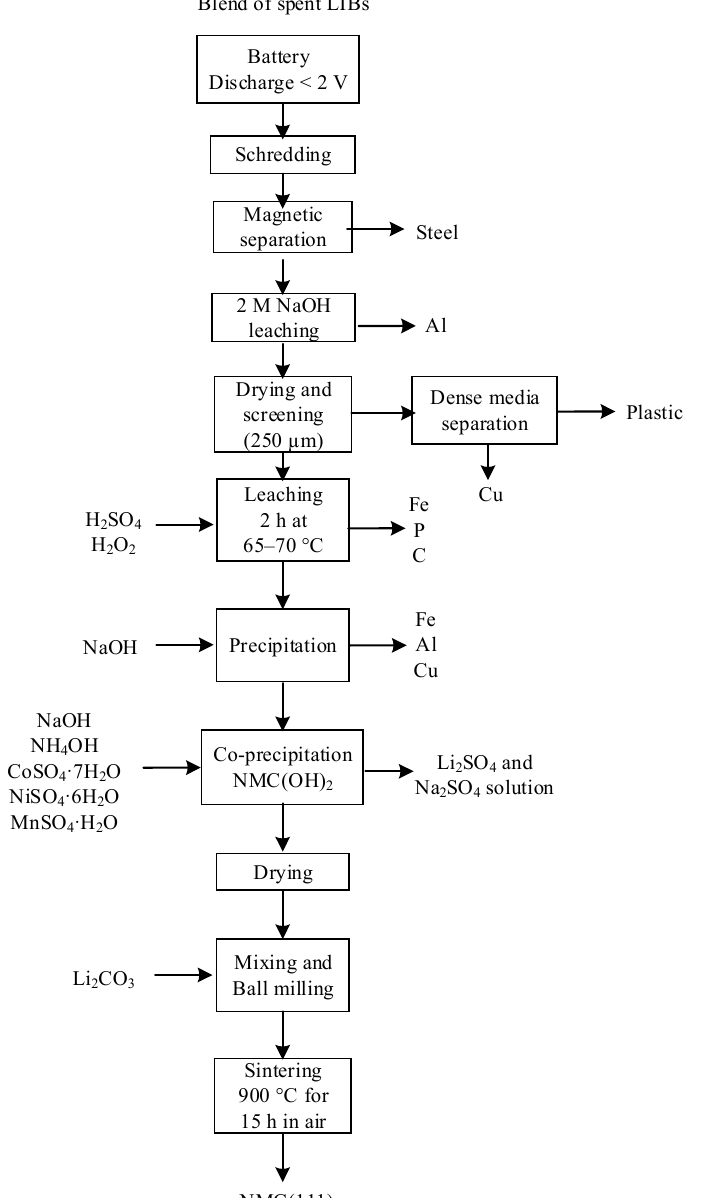
Figure 10. Selective leaching process proposed by Zheng et al. (according to Ref. [85,126]); here, NMC(OH) 2 and NMC(111) are Ni 1/3 Mn 1/3 Co 1/3( OH) 2 and LiNi 1/3 Mn 1/3 Co 1/3 O 2 , respectively.